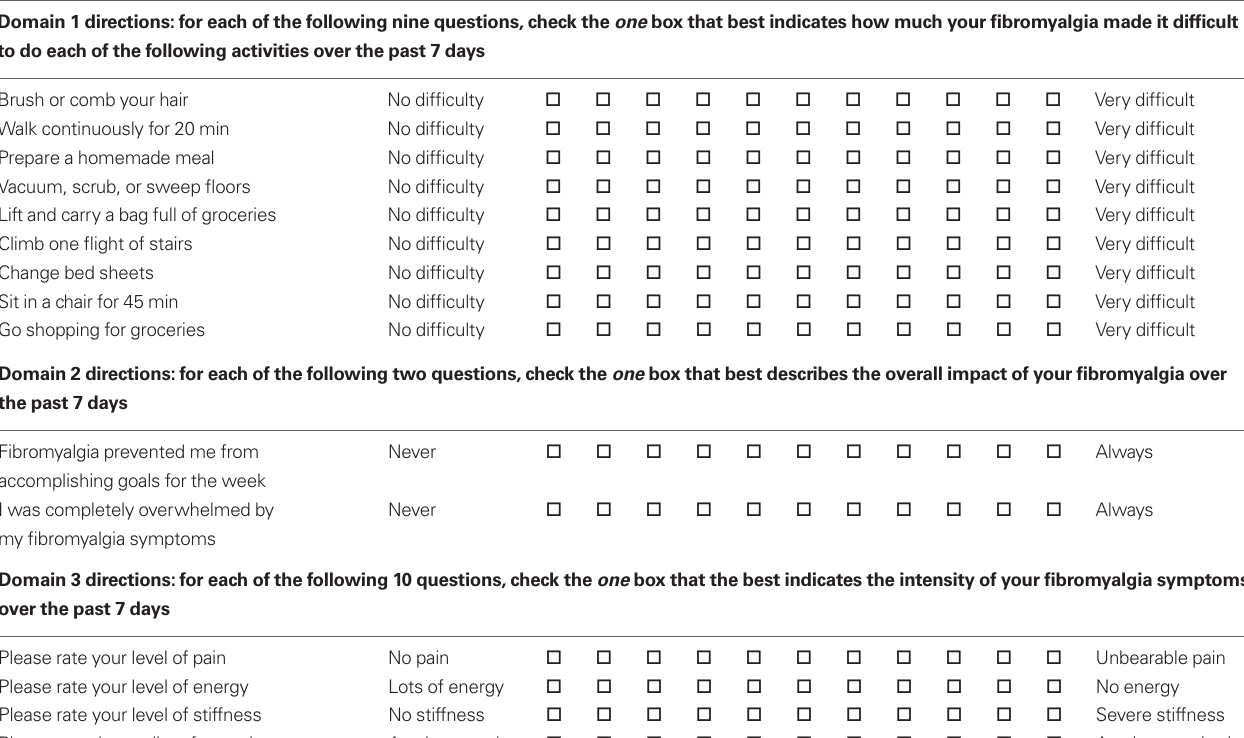
Table 1 | revised Fibromyalgia impact Questionnaire